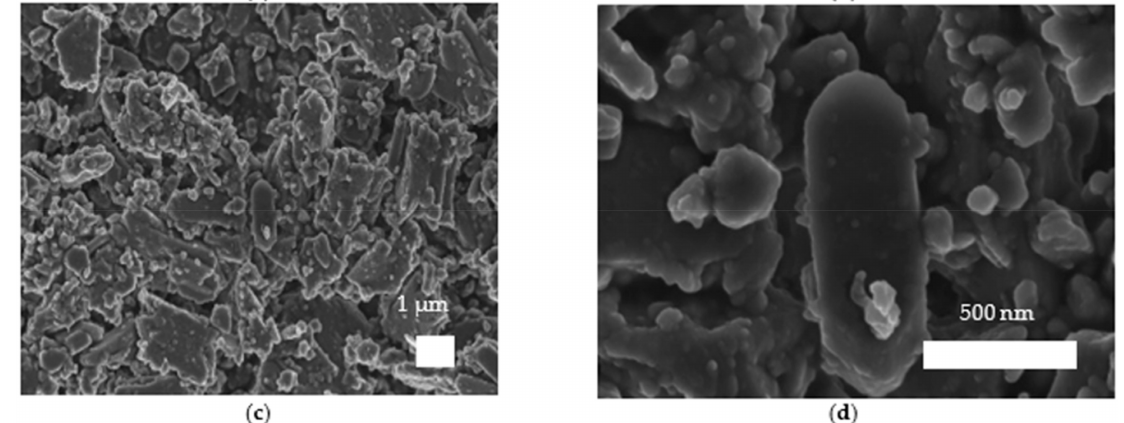
Figure 7. CaOx precipitates obtained during the post-nucleation stage in the absence of PAA. ( a , b ) TEM image and SAED pattern of hexagonal ACO nanoparticles, ( c , d ) FESEM images of different nanoparticles composed of platy euhe- dral nanoparticles.